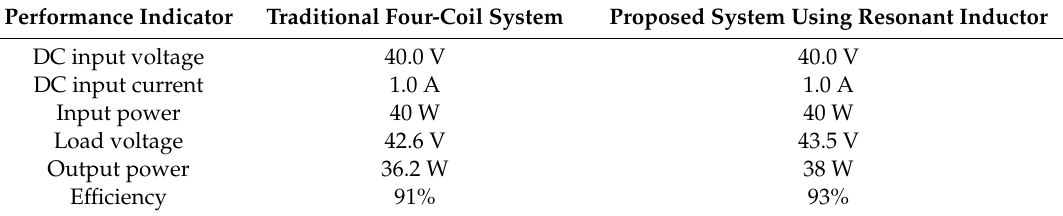
Table 6. Performance comparison of two types of WPT systems.